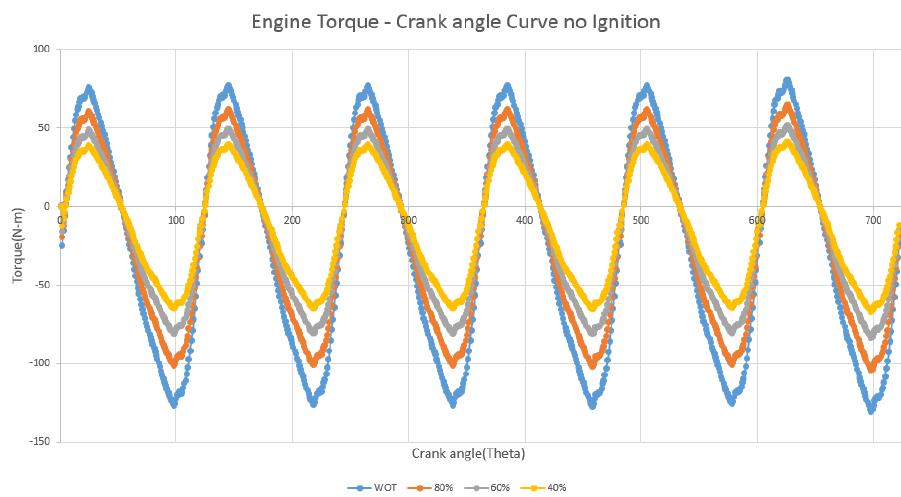
Figure 4. Output torque Internal combustion engine without ignition.